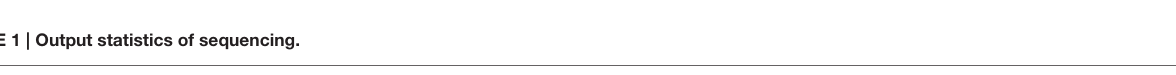
FIGURE 1 | The symptoms of mango bud after infected by F. mangiferae . CK is healthy seedling; 45D, 75D, and 120D were vegetative malformation of mango artificially after inoculated with F. mangiferae.